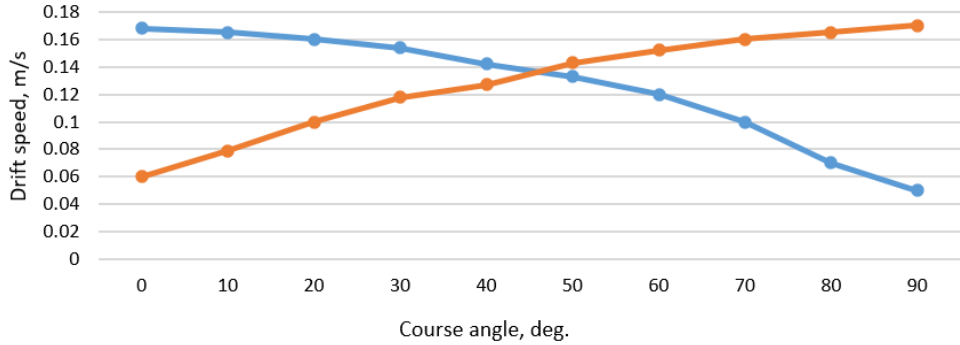
v v —blue line; dY —red line) during departure from